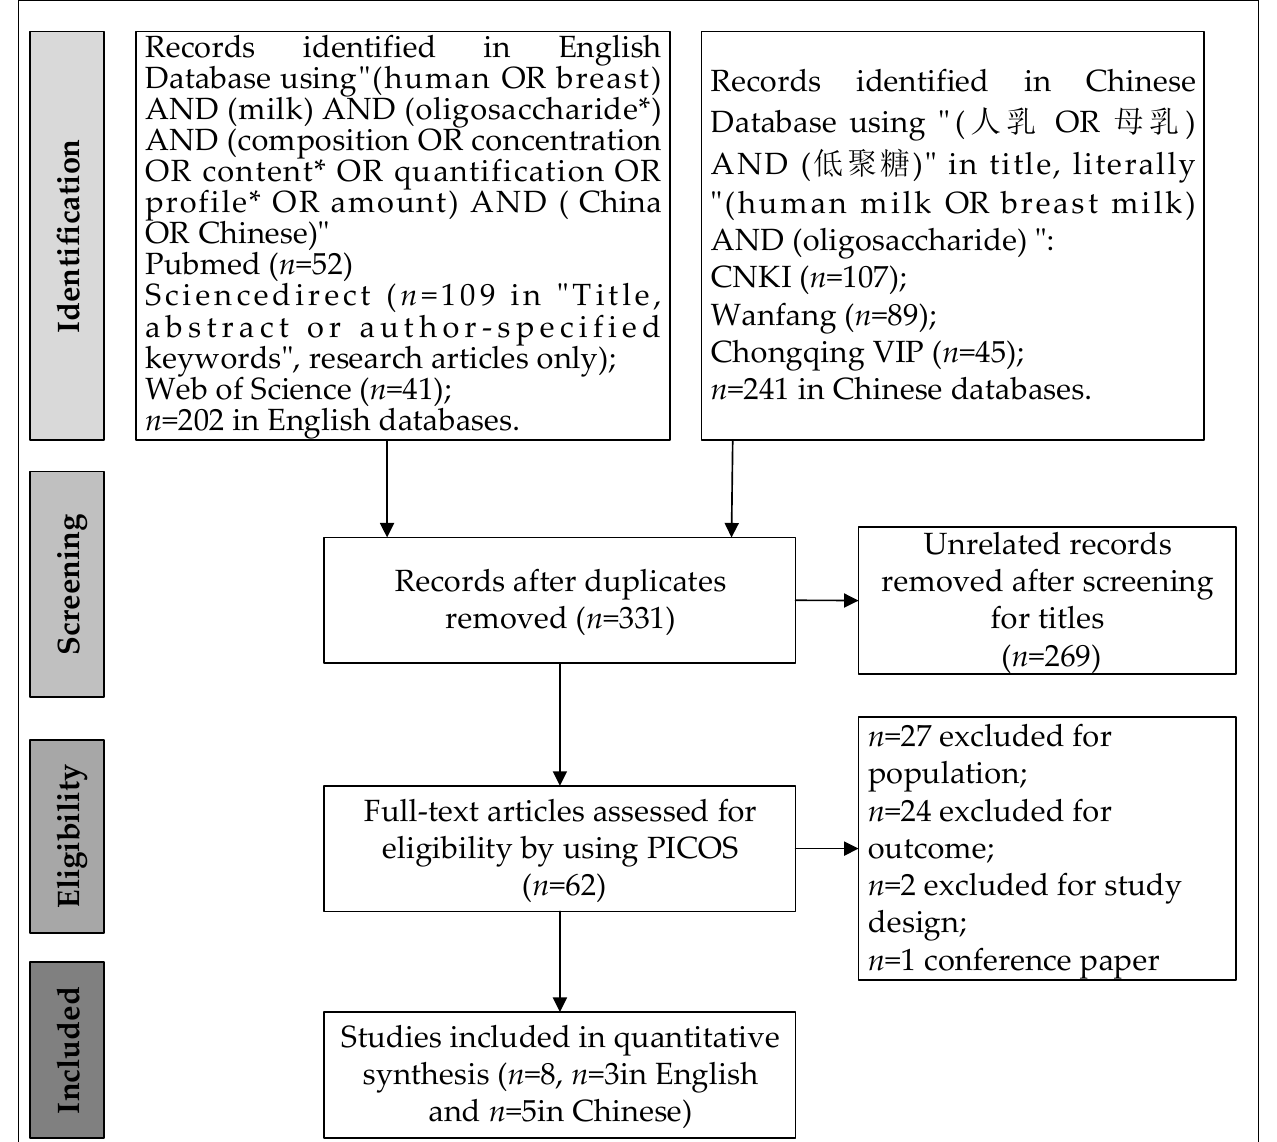
Figure 1. Flow chart of literature searching and screening.